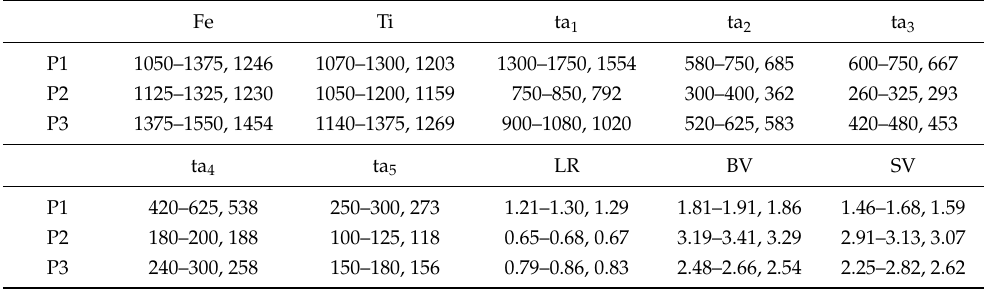
Table 2. Male adults of Microtendipes baishanzuensis sp. nov. Length (in µ m) and proportions of leg ( n =